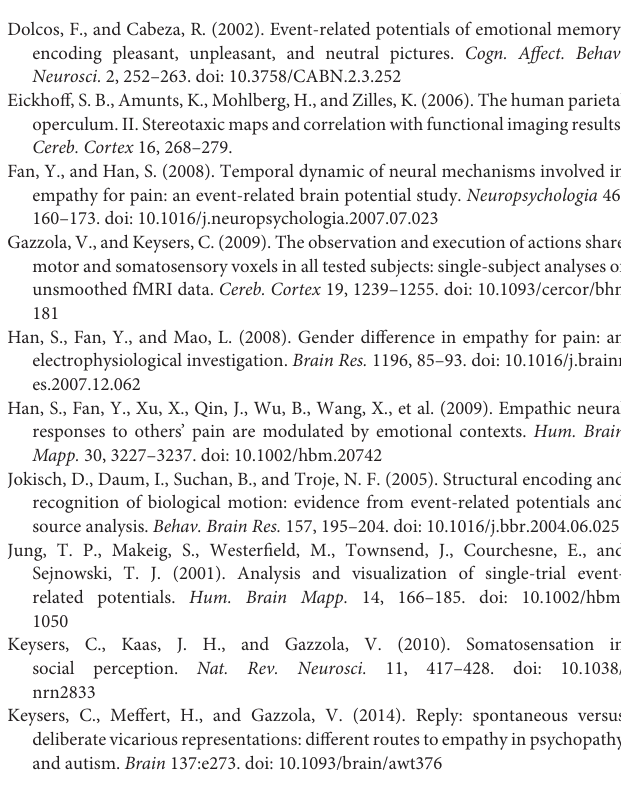
FIGURE S1 | (A) The EEG signal before and after using independent component analysis (ICA) removing the artifact of eye blink and (B) the component reflecting the eye blinks identified using ICA (marked with yellow circle). TABLE S1 | Two categories of objects: noxious and neutral with eight objects in each